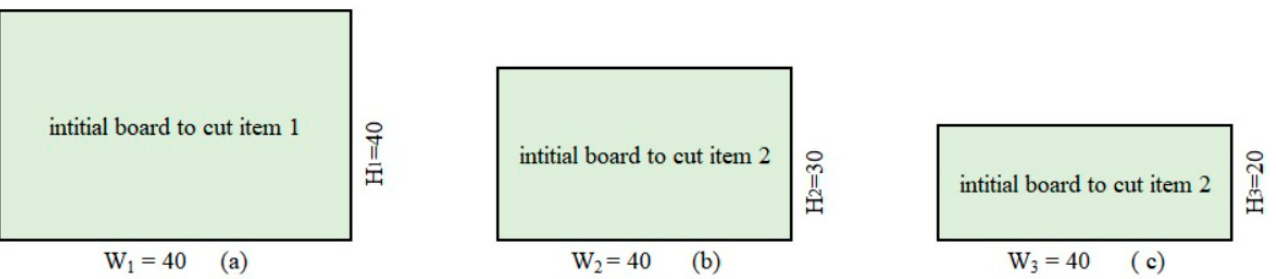
Figure 1. Initial boards in first phase of cutting items of Example 1.